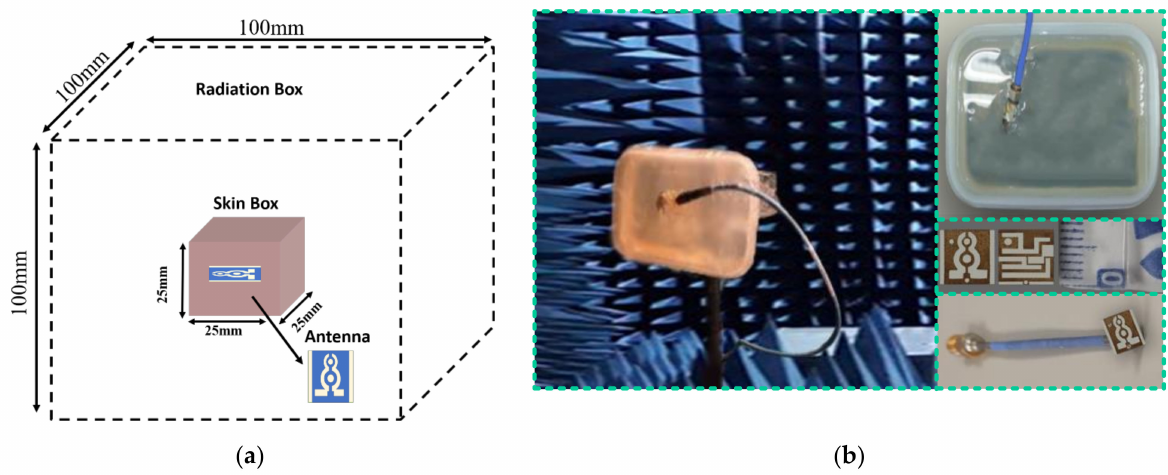
Figure 8. Antenna inside skin-mimicking-gel; ( a ) perception view and ( b ) the experimental setup to measure the radiation pattern and S 11 inside the skin.